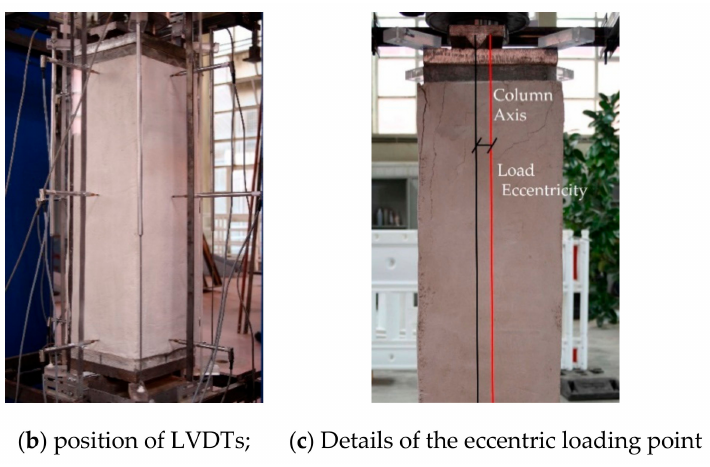
Figure 7. Test set up.